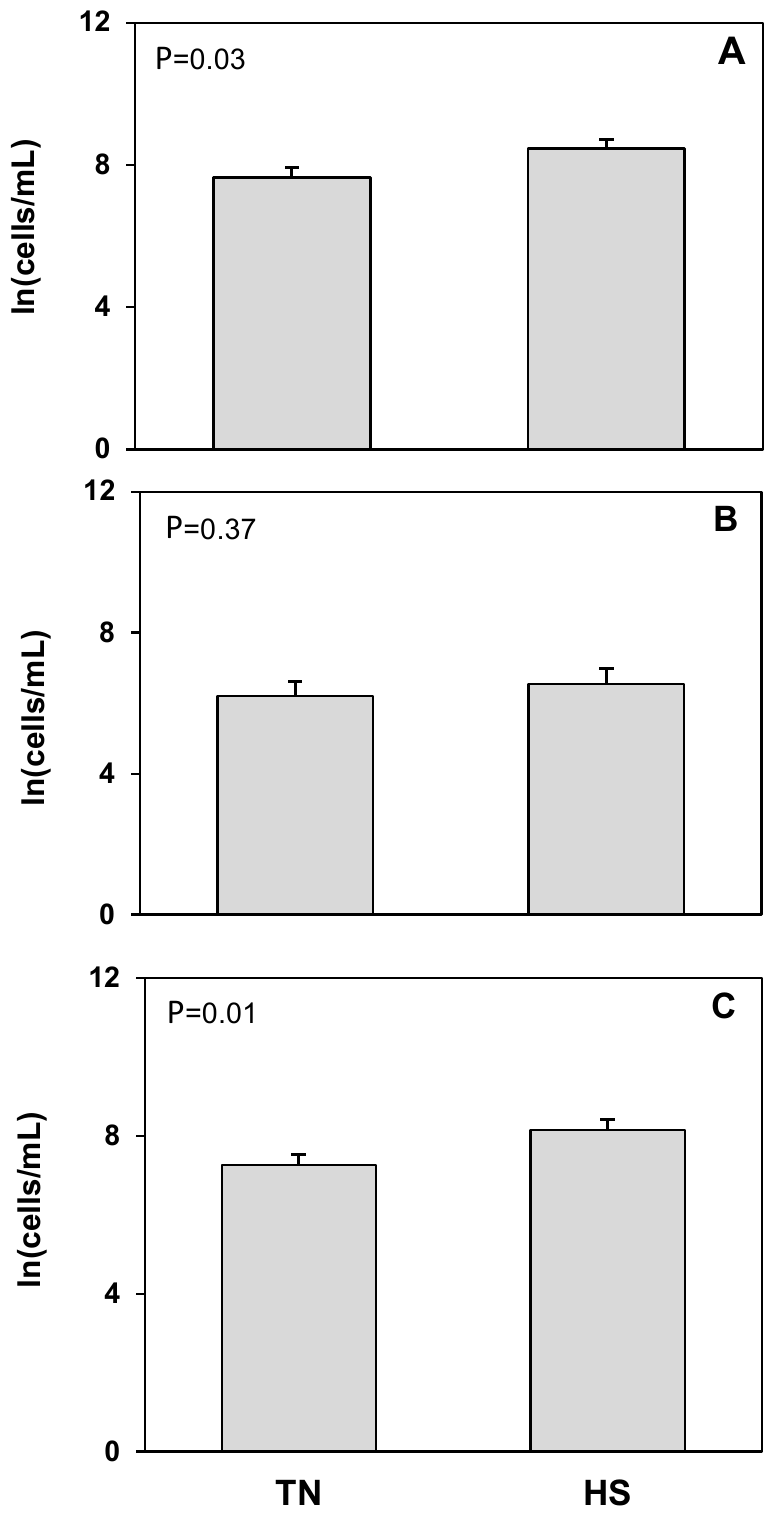
Figure 6. Heat stress (HS) impacts on CD14 positive, but CD45 negative (CD14 + CD45 − ) cell concen- tration in milk compared to thermoneutral (TN) conditions. ( A ) Total cells, ( B ) live cells (propidium iodide negative; PI − ), and ( C ) dead cells (propidium iodide positive; PI + ). Cell population data were natural log transformed for statistical analysis. Values presented are least square means of natural log transformed data with error bars presenting the SEM (n = 10).